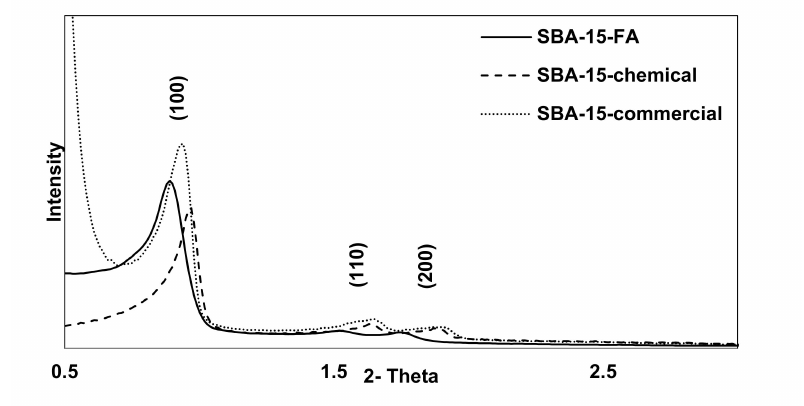
Figure 1. Small-angle of XRD pattern of SBA-15